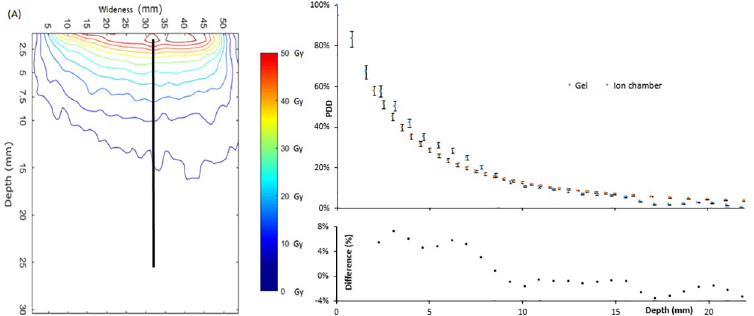
Fig 4. Dose distribution in gel. (A) Isodose map obtained for the irradiation dose level of 50 Gy. The black line defines the position of the Percent Depth Dose (PDD). (B) Normalized PDD measured from gel (blue) and from ion chamber (orange) with respective error bars. Indicative point of normalization at 0 mm for the ion chamber is obtained by extrapolation with an exponential fit.